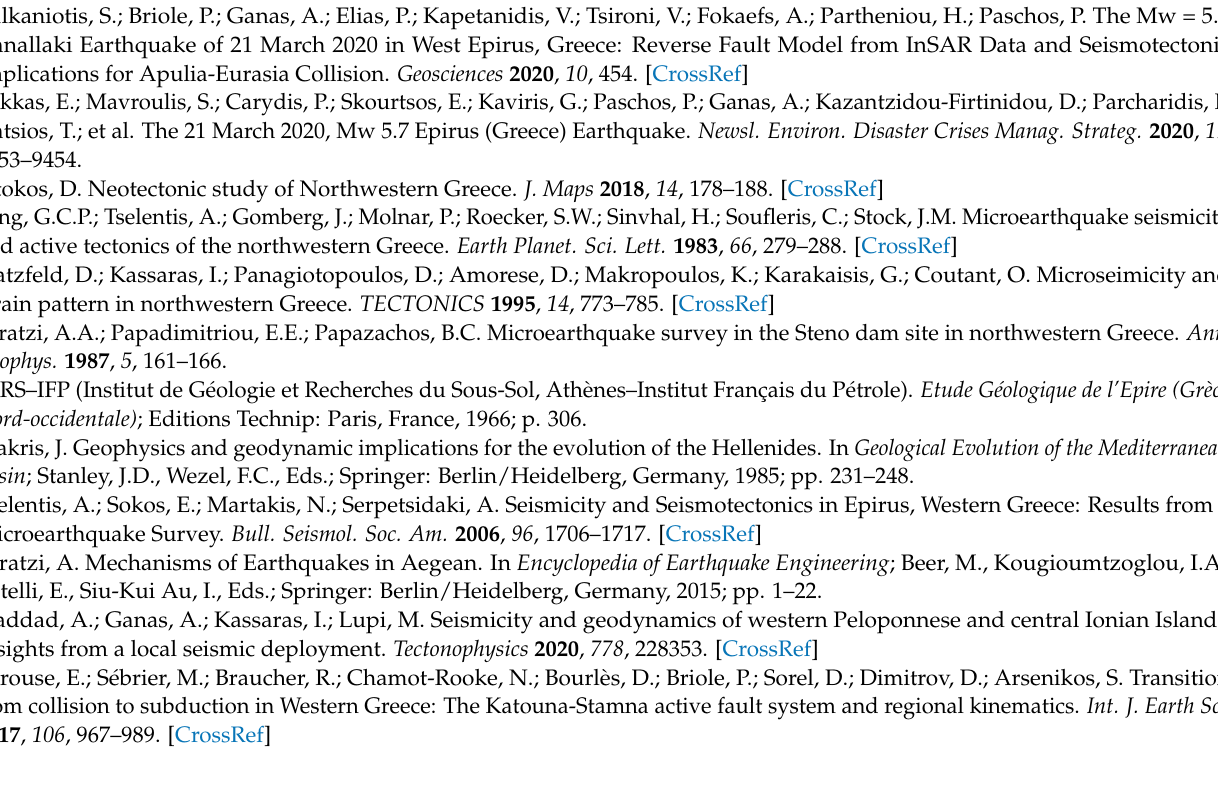
Table S1: RMS InSAR non-linear